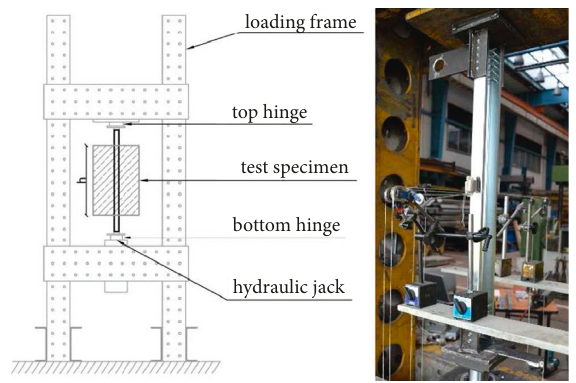
Figure 1: Loading frame of the specimen tests [1].